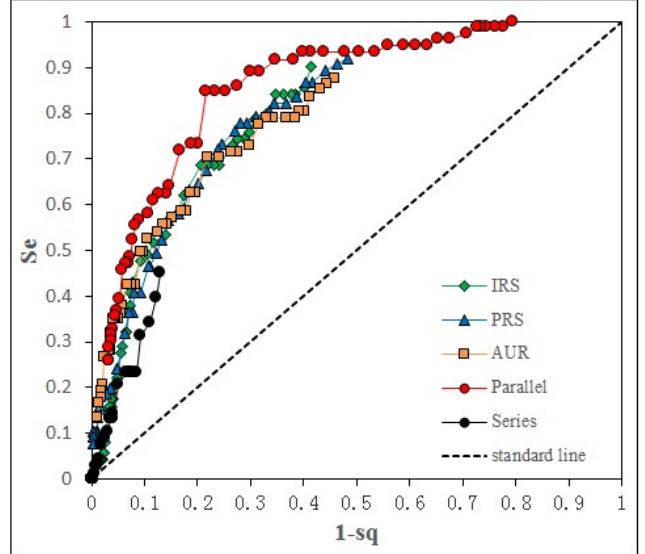
Figure 3. The ROCs of five warning strategies of process data for identifying signals of HAI clusters. Fifty-one thresholds (0.0 to 5.0 step by 0.1) were used for detecting clusters of process data. Dots indicate the sensitivities and 1-specificities for each threshold. AUR: Antibiotic utilization rate in combination; IRS: Inspection rate of bacterial specimens; PRS: Positive rate of bacterial specimens.